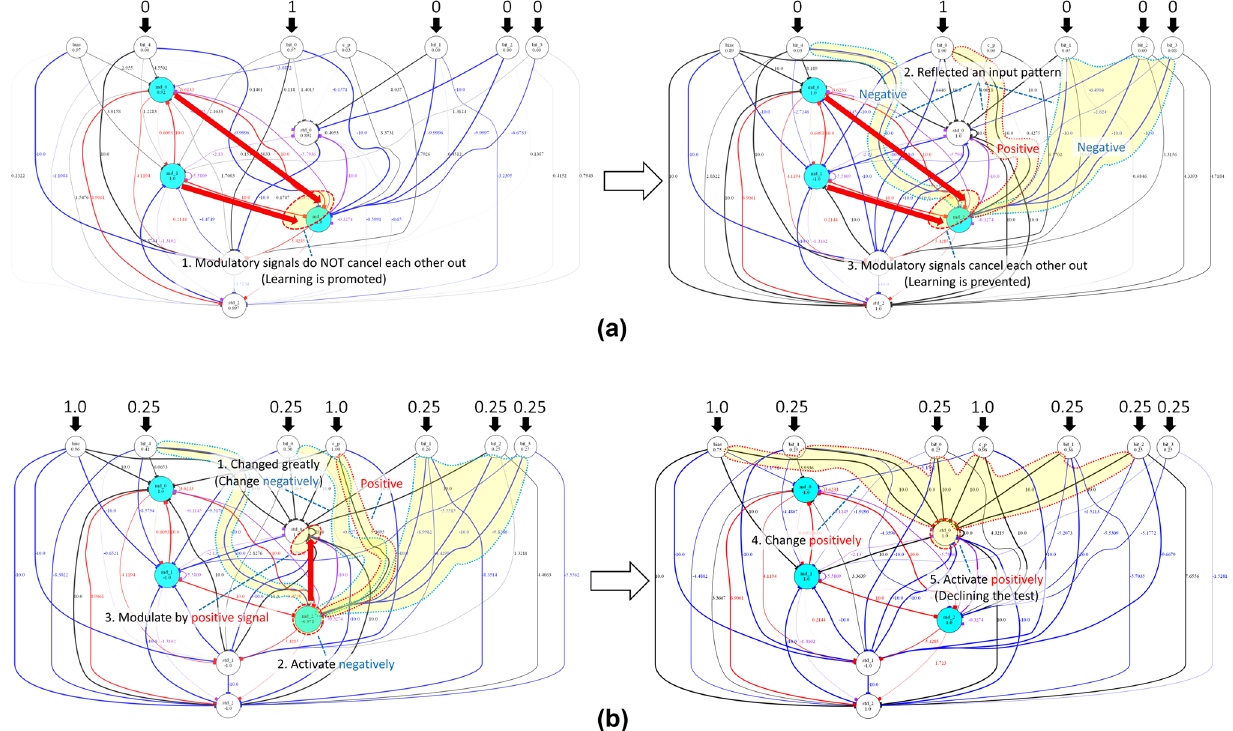
Figure 10. The mechanism by which the network memorizes and maintains a target pattern (00001), and declines the test. Each red arrow represents a modulation. Each event occurs in numerical order. ( a ) The mechanism for memorizing and maintaining a target pattern in the study phase. (1) Learning of connection weights is promotedbecause the modulatory signal from md_0 to md_2 and that from md_1 to md_2 do not cancel out each other. (2) Consequently, signs of someconnections reflect a structure comprising 0 and 1 of an input pattern. (3) Thereafter, the modulatory signals cancel out each other and learningis prevented. In other words, the reflected information is protected. ( b ) The mechanism of declining the test in the choice phase. (1) If the connections in which an input pattern is memorized changesignificantly, md_2 (core modulatory neuron) receives the inputs in which the sum is negative from bit_0,..., bit_4 and c_p (where c_p acts asa bias, to judge whether the agent forgets or not). (2) Consequently, md_2 activates negatively, and (3) the plasticity of the learning of someconnections which connect to std 0 (the declining neuron) is modulated by the positive signal from md_2. (4) Accordingly, the connectionsthat connect to std_0 change positively, and (5) std_0 activates positively and the network declines the test.